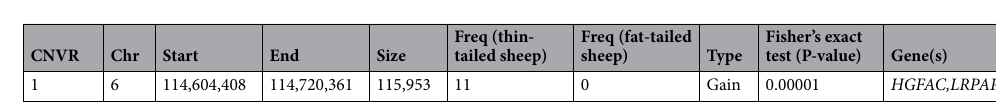
Figure 4. Genomic distribution and status of detected CNVRs in Iranian sheep breeds with two different types of tails.